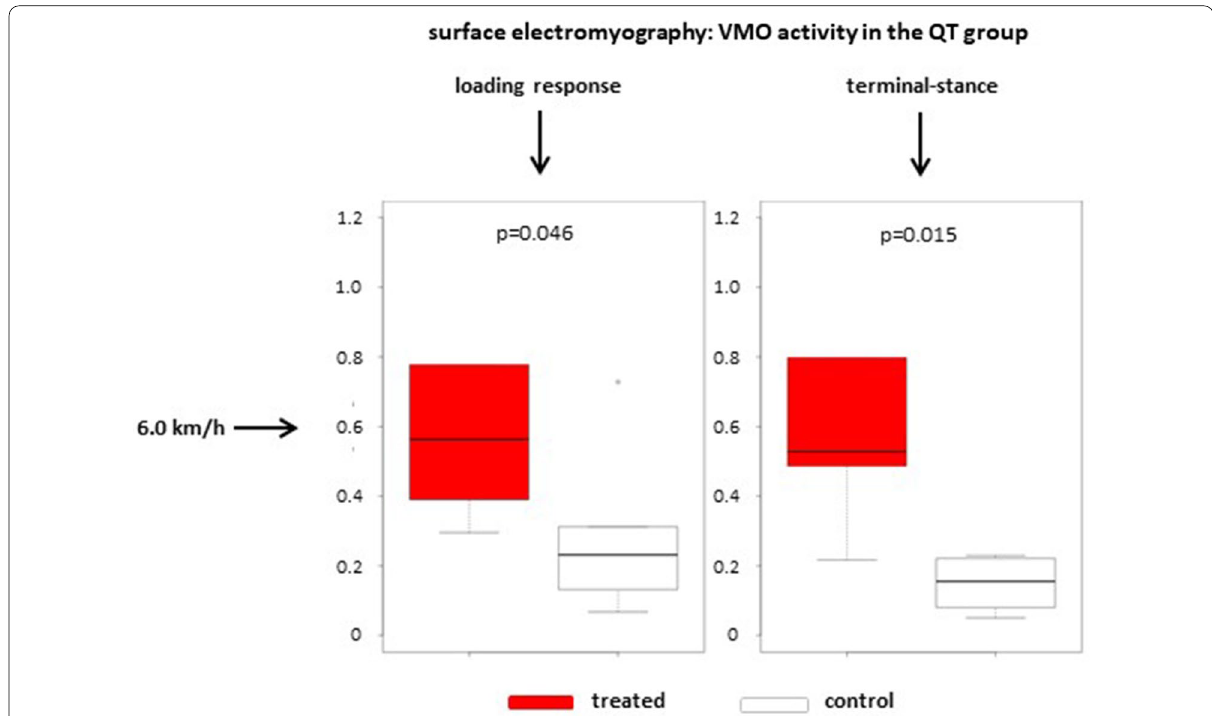
Fig. 3 Boxplot charts showing VMO activity (µV) for the treated and contralateral side in the QT group during loading response and terminal stance at 6.0 km/h. In both phases, there is a significant difference between the treated and contralateral intact